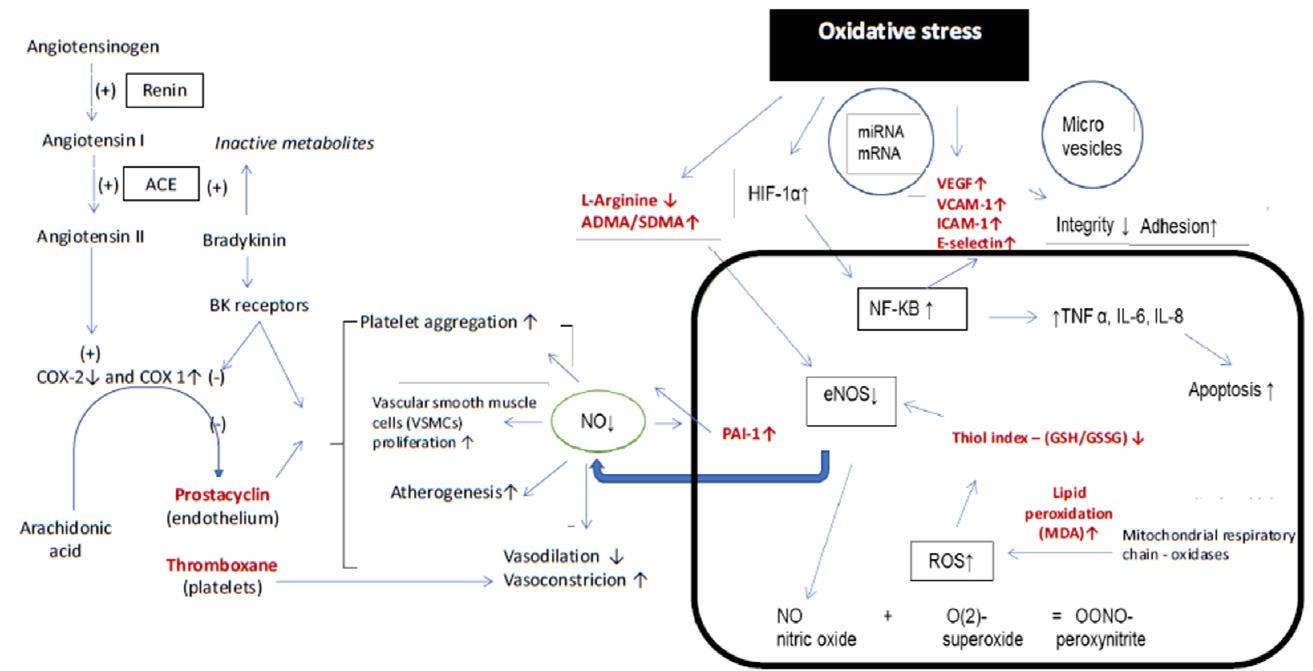
Figure 1. The links between the renin-angiotensin-aldosterone system, arachidonic acid cascade, endothelial dysfunction, and oxidative stress. The parameters analyzed in this study are marked in red. ADMA—asymmetric dimethylarginine, COX-cyclooxygenase, ACE—angiotensin converting enzyme, BK receptors—receptors for bradykinin, NO—nitric oxide, PAI-1—plasminogen activator inhibitor—1, MDA—malonyldialdehyde, GSH—reduced glutathione, GSSG- oxidized glutathione, eNOS—endothelial nitric oxide synthase, NF-KB—nuclear factor-kappa B, TNF α —tumor necrosis factor alpha, IL-6 and IL-8—interleukin 6 and 8, HIF 1 α —hypoxia-induced factor alpha, ICAM-1—intracellular adhesion molecule, SDMA—symmetric dimethylarginine, VCAM-1—vascular cell adhesion molecule, VEGF—vascular endothelial growth factor.